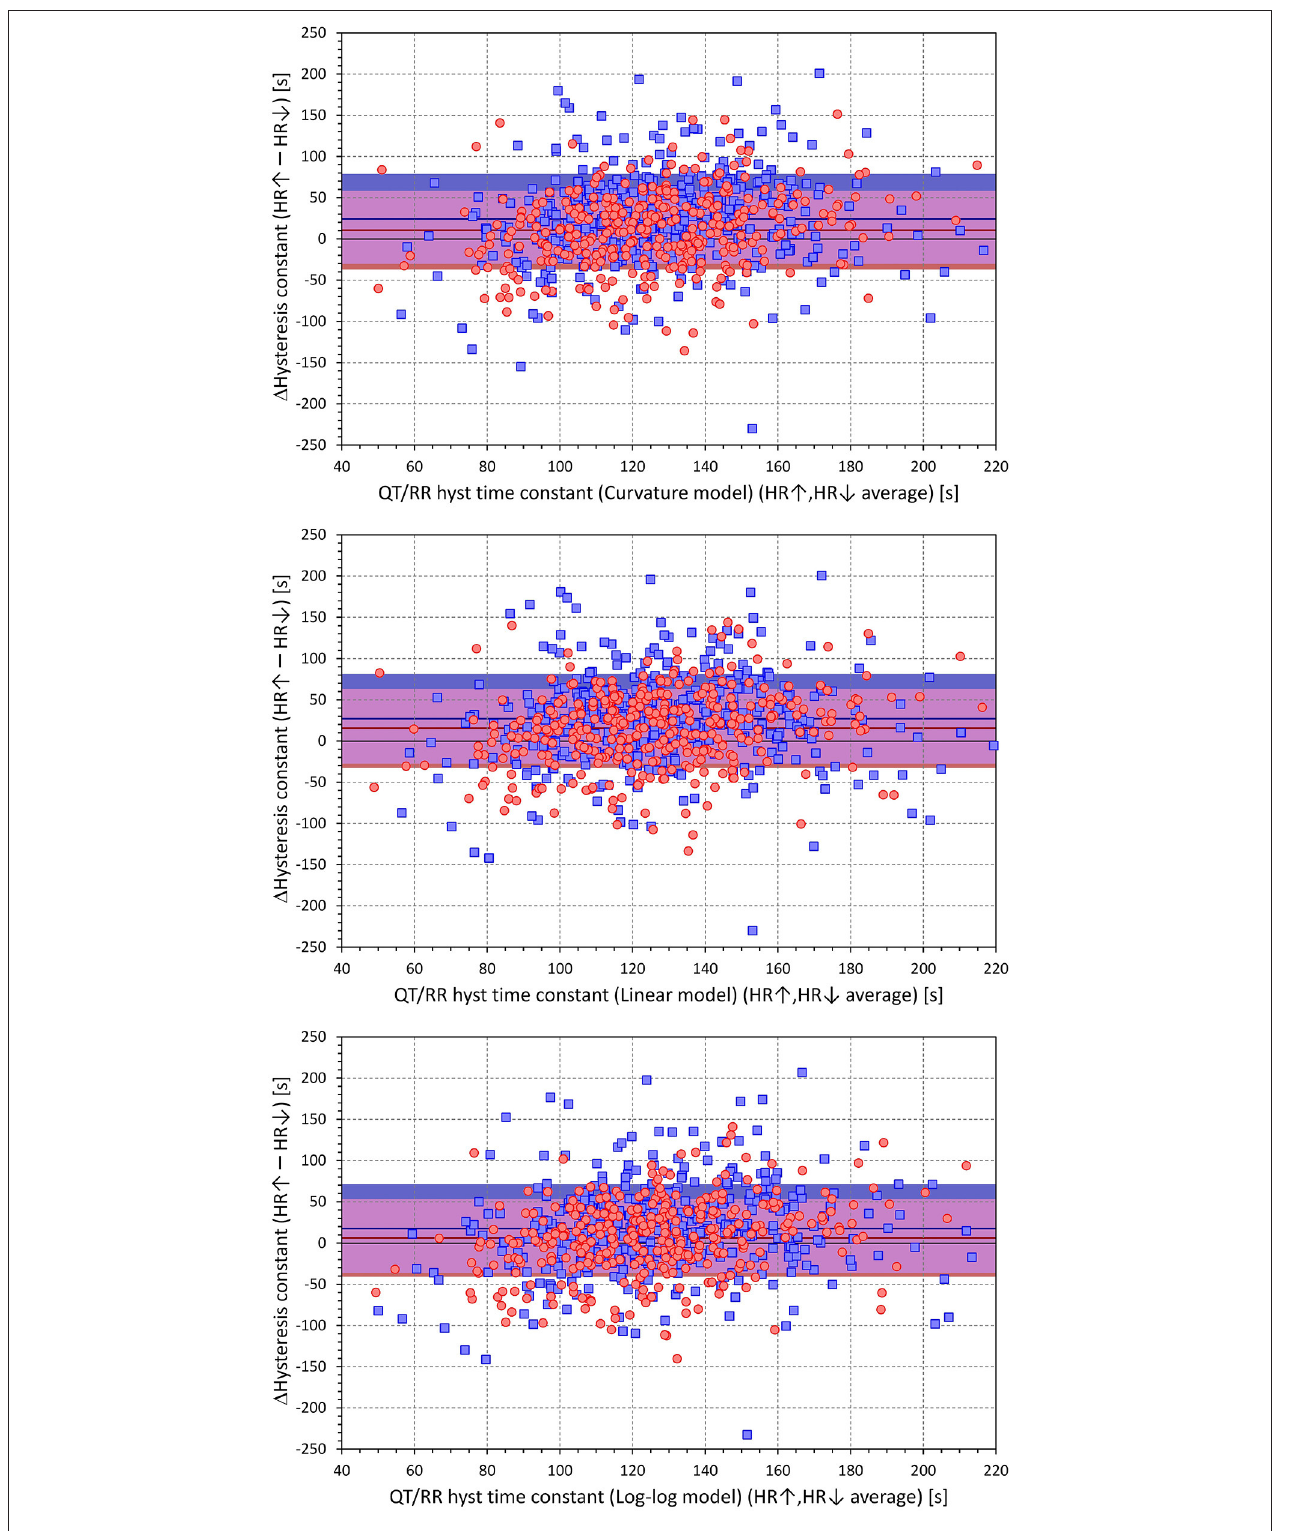
FIGURE 13 | Scatter diagrams of subject-specific differences among hysteresis time constants during heart rate acceleration and deceleration plotted against their intra-subject averages. The top, middle, and bottom panels show the differences for the curvature, linear, and log-log QT/RR H models, respectively. In each panel, the red circle and blue square marks correspond to females and males, respectively. The red and blue horizontal lines show the mean values of the residual differences in females and males, respectively. The light-coloured red and blue bands show the spans of mean ± standard deviation of the residual differences in females and males, respectively; the light-coloured violet bands show the overlap of the mean ± standard deviation bands between both sexes.